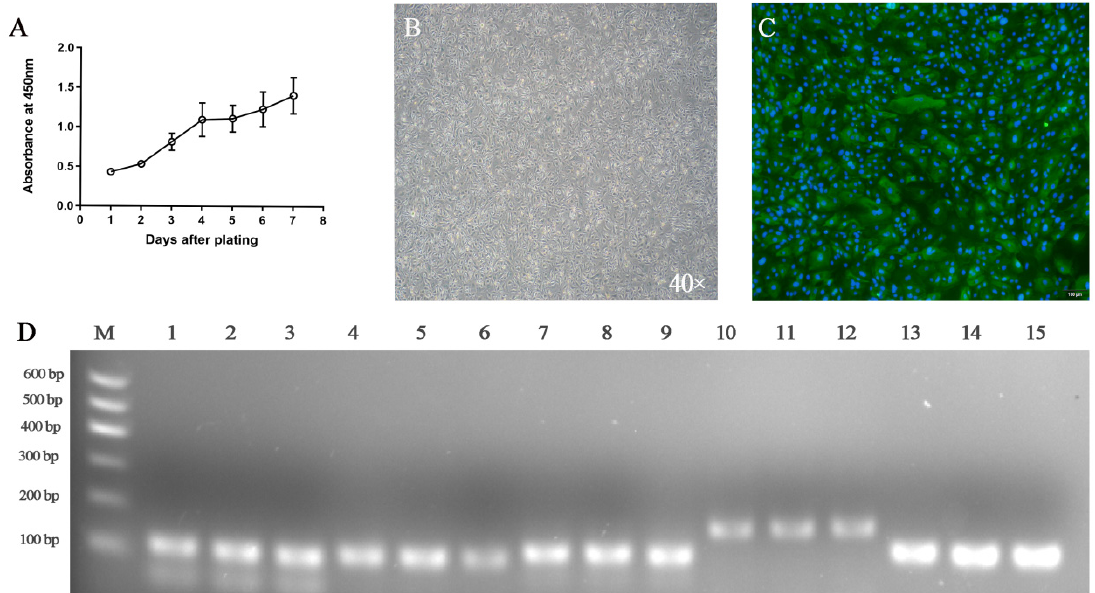
Figure 2. Characteristics of goat rumen epithelial cells. ( A ) Growth curve of GRECs in culture. Data shown are means ± SEM ( n = 3). ( B ) Analysis of GRECs senescence (100 × ). The appearance of blue is due to the expression of β -galactosidase, which indicates that senescence occurs in GRECs. ( C ) Immunoblotting of cytokeratin-18. Indirect immunofluorescence of cytokeratin 18 (green). Nuclei were stained with DAPI (blue). Bar = 100 µ m. ( D ) RT-PCR analysis of cell markers in GRECs. RT-PCR analysis of MCT4, NHE1, PAT1, vH + ATPas, and AE2; amplifications of GREC-specific markers were obtained using primers directed against (lanes 1–3) MCT4, 106 bp, (lanes 4–6) NHE1, 113 bp, (lanes 7–9) PAT1, 123 bp, (lanes 10–12) vH + ATPas, 182 bp, and (lanes 12–15) AE2, 123 bp. M molecular weight standard in bp. The data were based on triplicate